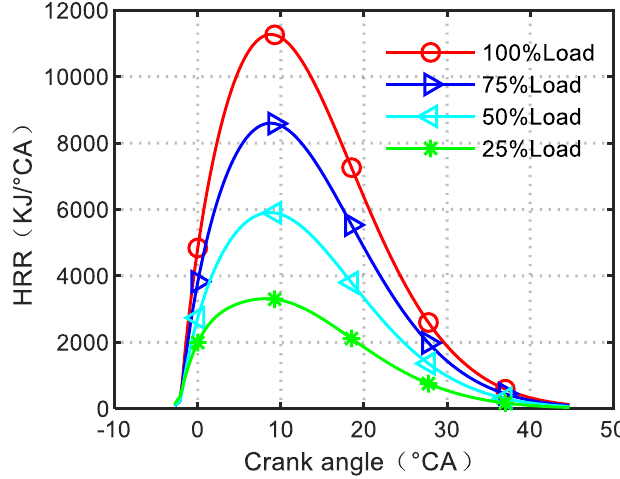
Figure 10. Cylinder heat release rate simulation curve.